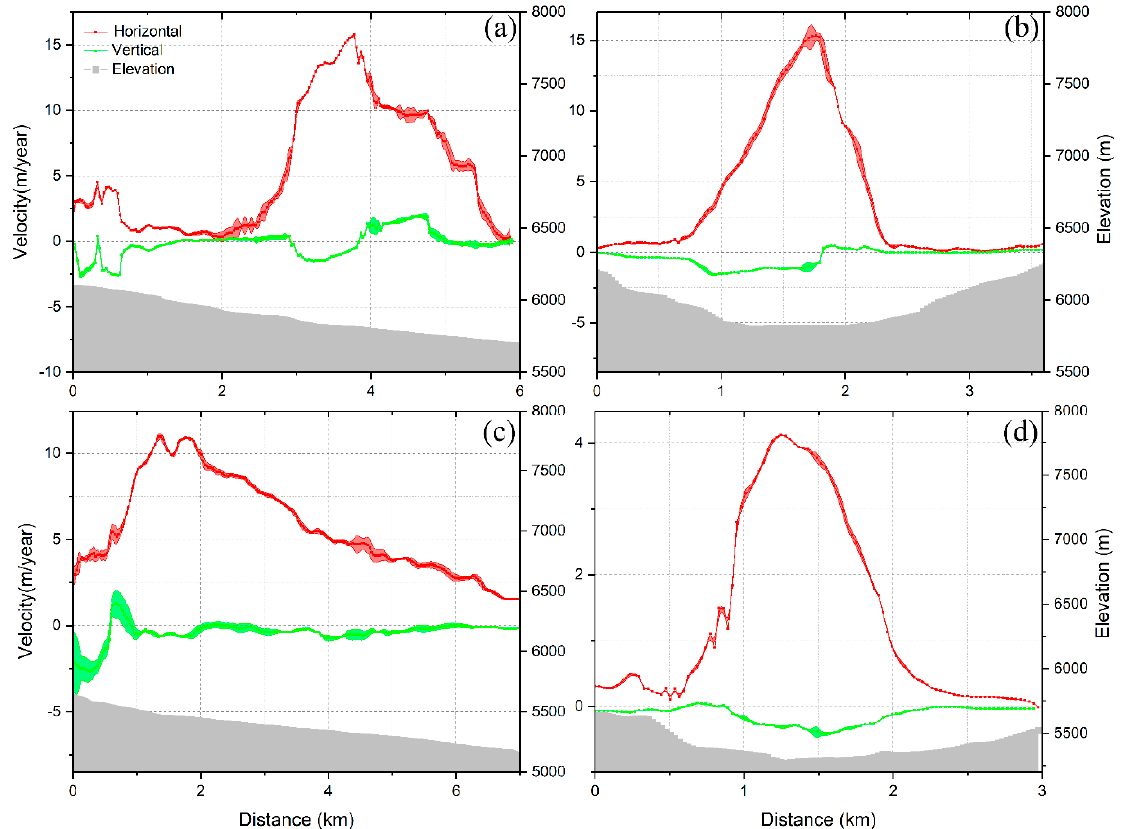
Figure 5. 3D velocities and elevations of glacier No.1 and glacier No.2 in 2018, where red and green lines represent the horizontal and vertical annual velocity, respectively. Profiles of AA’ and BB’ are shown on Figure 4a and profiles of CC’ and DD’ are shown on Figure 4b. The error bar indicated the standard deviation of the velocity in the area near the selected profiles. ( a ) Profile A-A’; ( b ) Profile B-B’; ( c ) Profile C-C’; ( d ) Profile D-D’ .